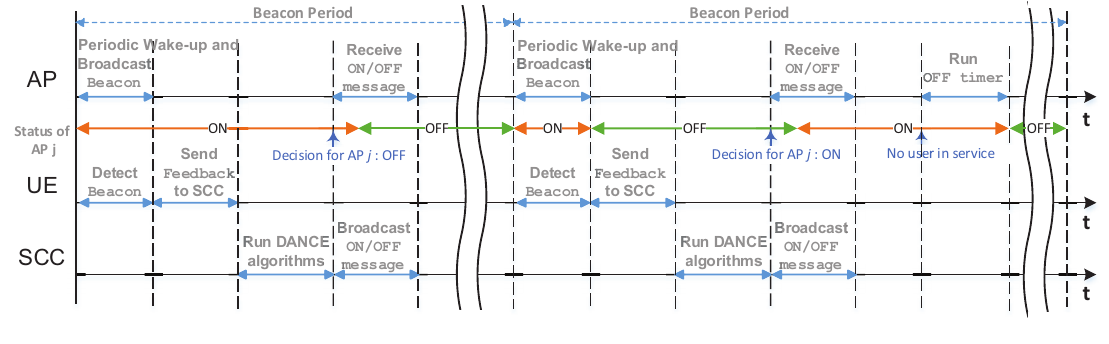
Figure 3. Green small cell operation and procedure using the DANCE algorithm.